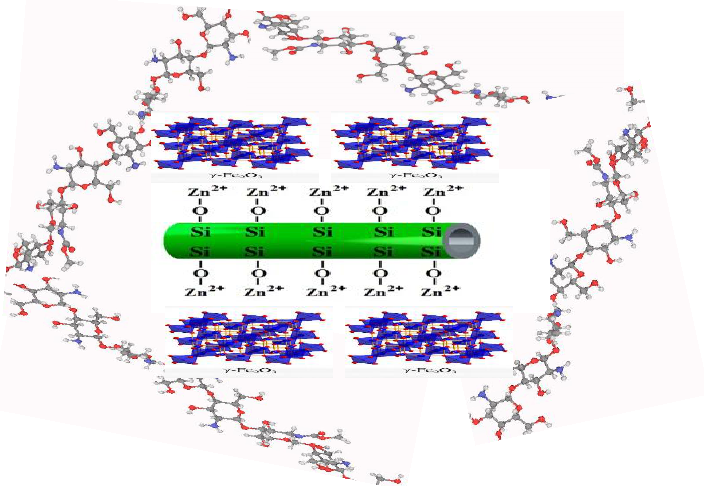
Figure 3. Scheme of the predicted shape of the synthesized quaternary magnetic nanocomposite Ch/g-HNTs@Zn M.